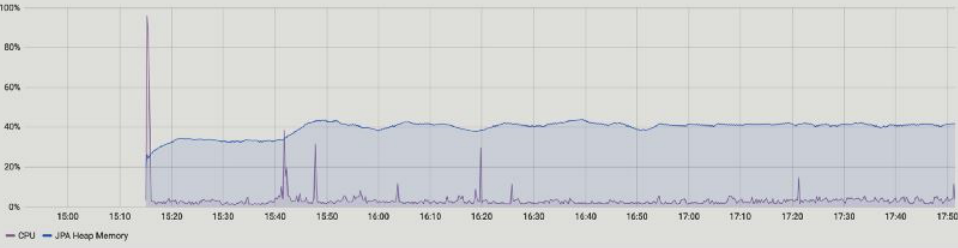
Figure 8. Overhaul CPU